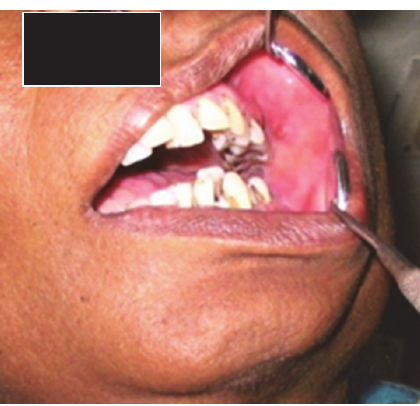
Figure 1: Intraoral view showing limited jaw movements with mild cortical plate expansion.